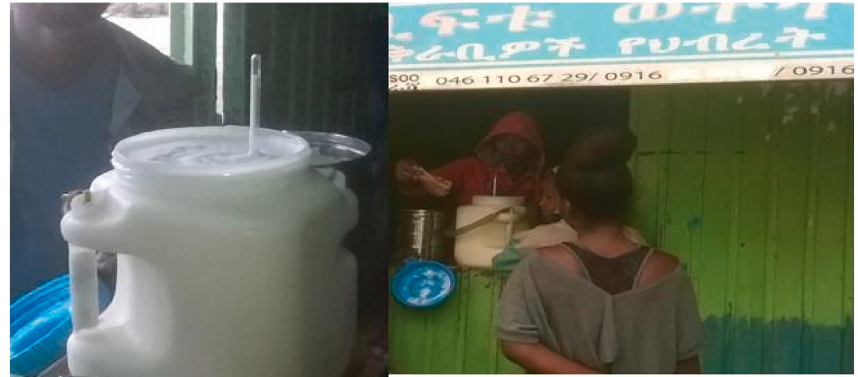
Figure 5: Milk quality controlling system of collectors at the collection point